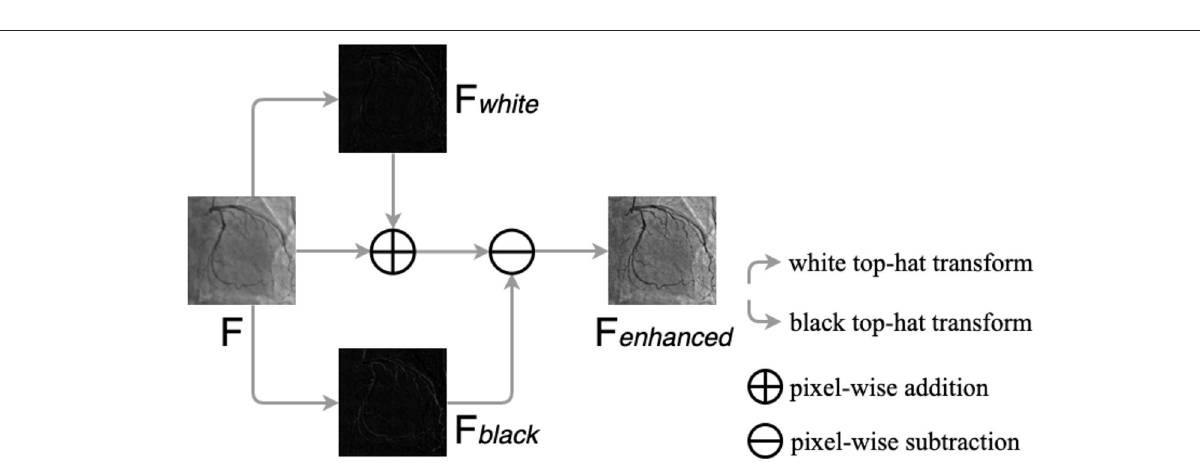
FIGURE 5 | The procedure of the top-hat transforms. F is the original gray angiogram image, F white and F black are obtained by white and black top-hat transform, respectively. F enhanced is the enhanced angiogram